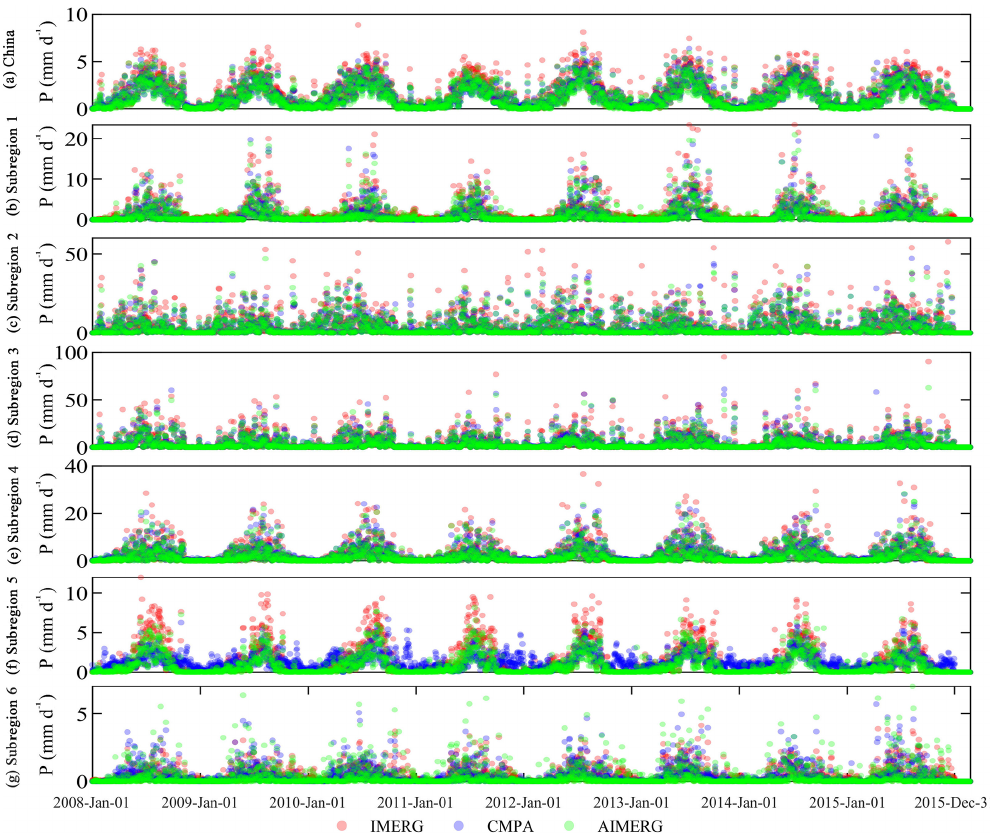
Figure 6. The temporal patterns of mean areal precipitation of IMERG, CMPA, and AIMERG over mainland China and subregions from 2008 to 2015, at a daily